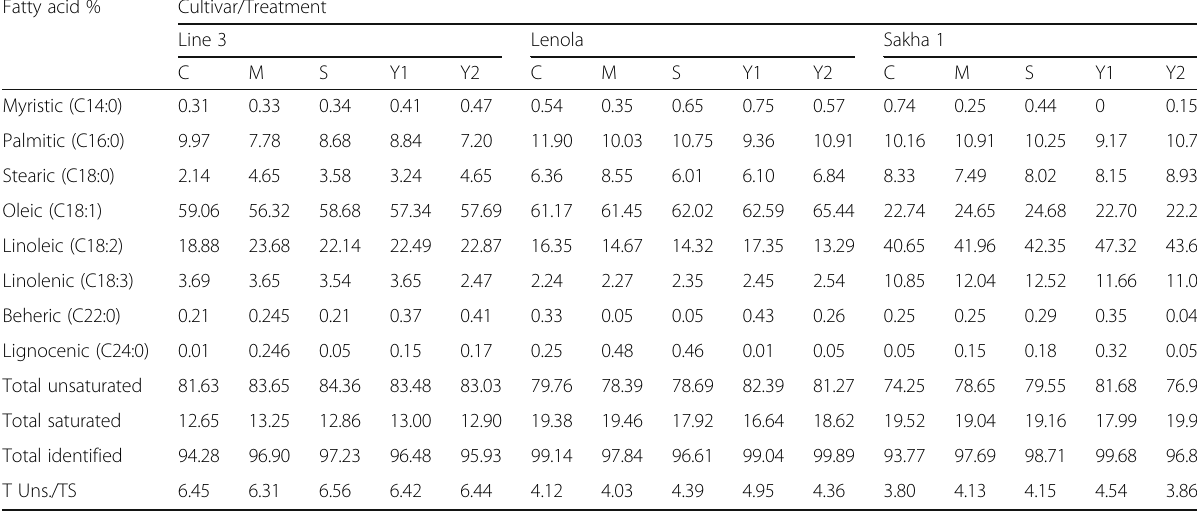
Table 11 Effect of interaction between flax cultivars and bio-fertilizer treatments on fatty acid composition of the yielded oil Fatty acid %